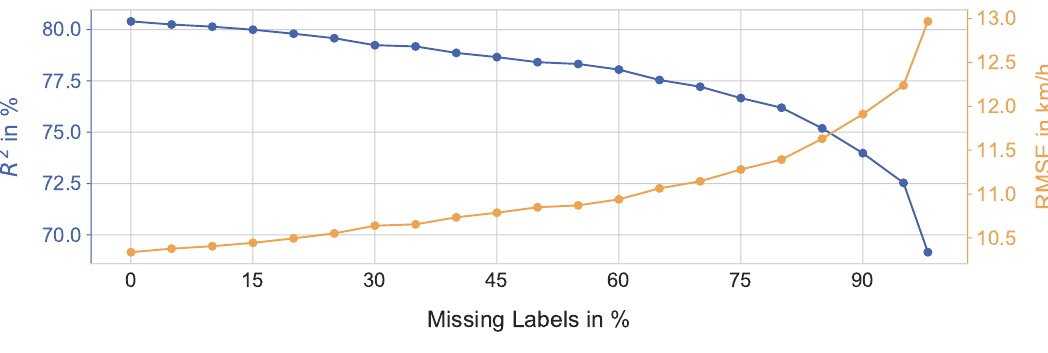
Figure 6. Prediction quality of the ET model with the Basic input features and with focus on the percentage of missing labels of the combined training dataset.